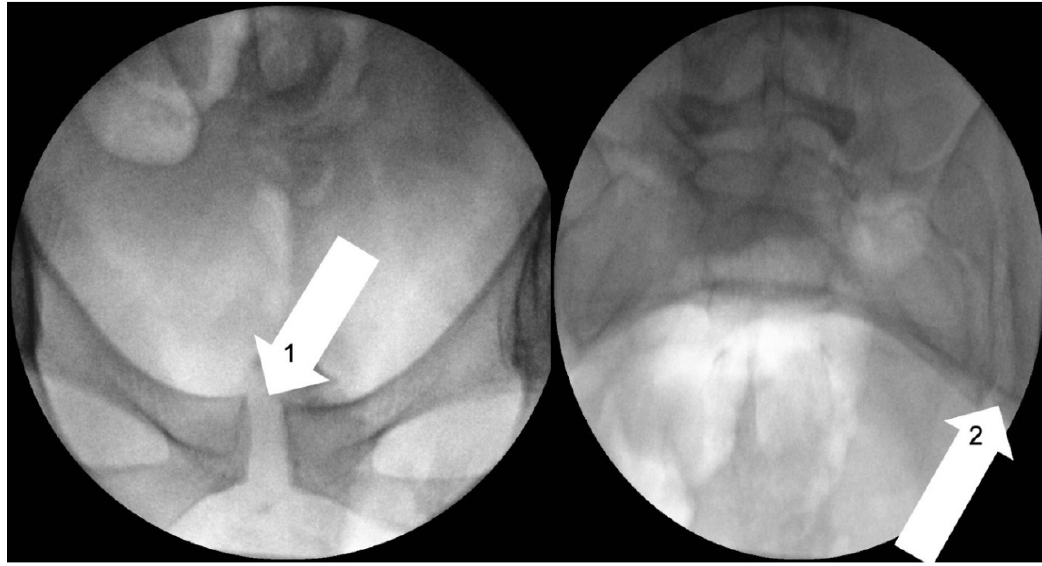
Figure 4. Fluoroscopic stress pelvic views radiograph in a 30-year-old female suffering from hypermobility syndrome demonstrating widening of pubic symphysis (Arrow 1) and left sacroiliac joint (Arrow 2).